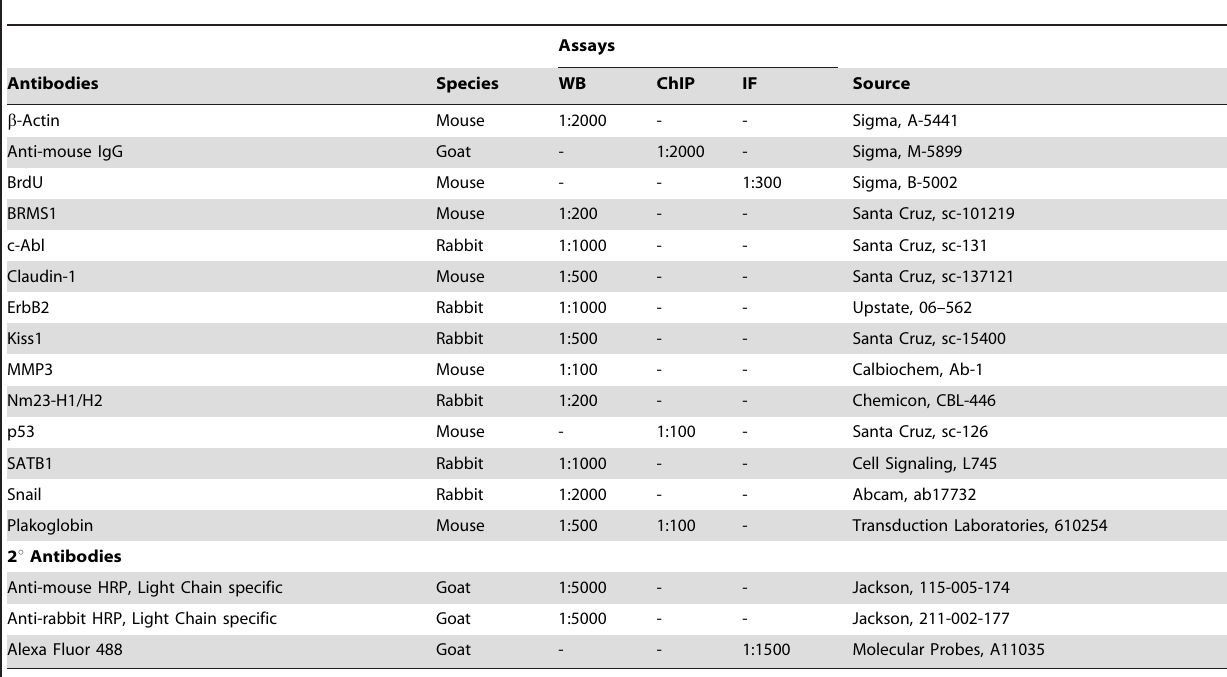
Table 2. Antibodies and their respective dilutions in specific assays.